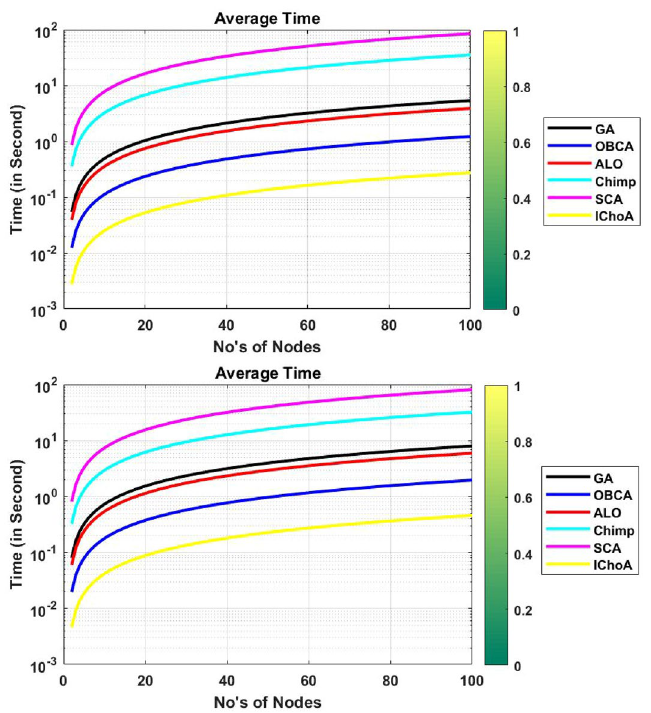
Figure 10. Average time consumption graphs of metaheuristics on functions F 2 and F 6